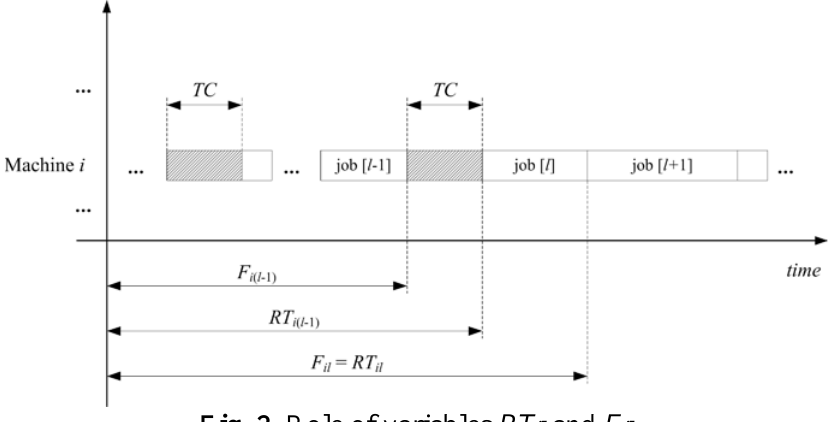
Fig. 2. Role of variables RT il and F il